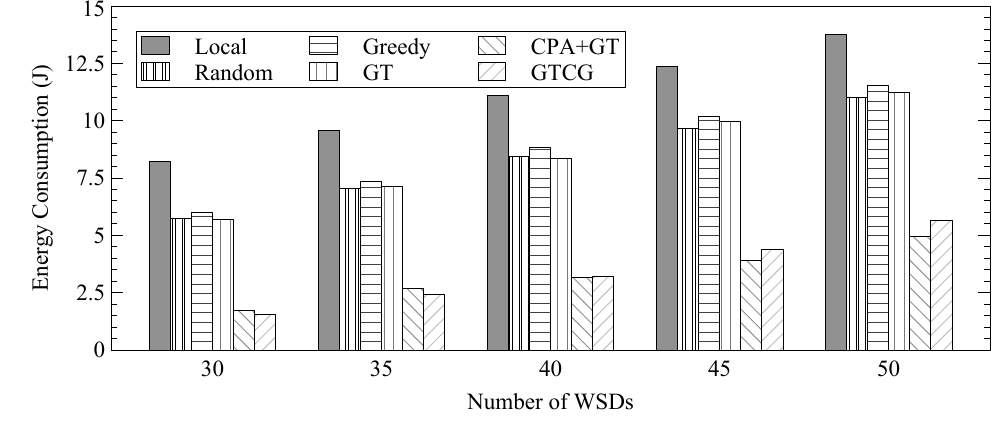
Figure 4. Average Energy Consumption for Different Number of WSDs.